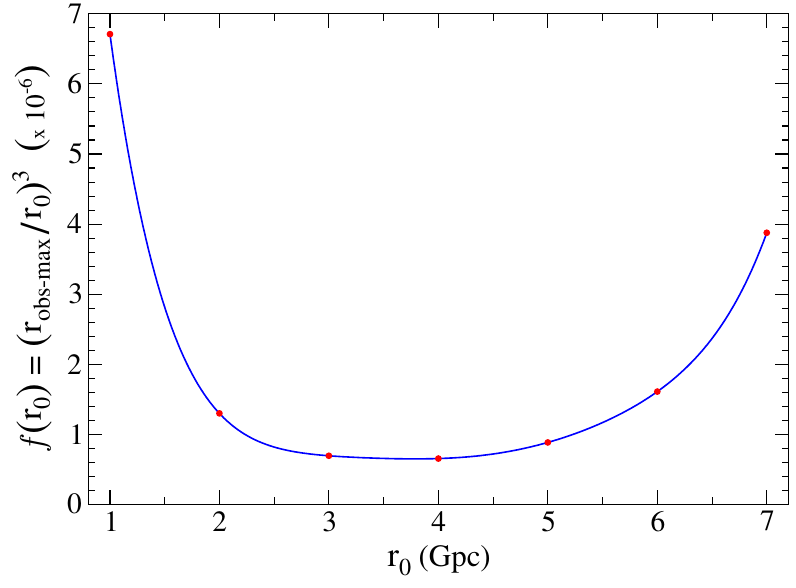
Figure 14. The spatial fraction f ( r confined in order to be consistent with the value of the observed CMB dipole, for ( r , Ω ) = (3 . 37 Gpc , 0 . 69) (from [86]). 0 X, in